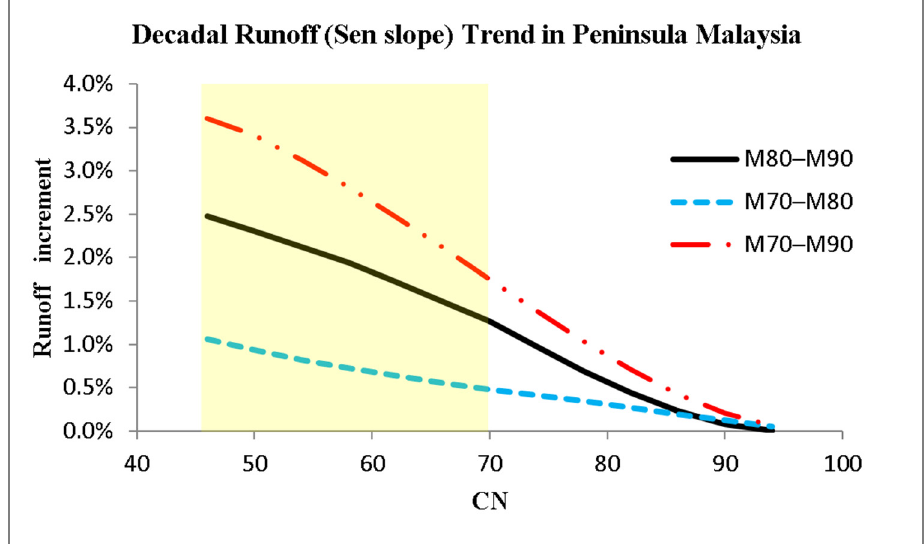
Figure 4. The Sen Slope for decadal runoff increment for CN 0.2 classes between M70 to M90. Sen slopes and inferential statistics were used to analyse the collective inter-decadal runoff increment conditions. Forested and rural areas are highlighted at lower CN 0.2 area from 46 to 70. The estimated percentage of rainfall depths by Sen slope calculation were compared between all scenarios to contrast the inter-decadal runoff incremental percentage.